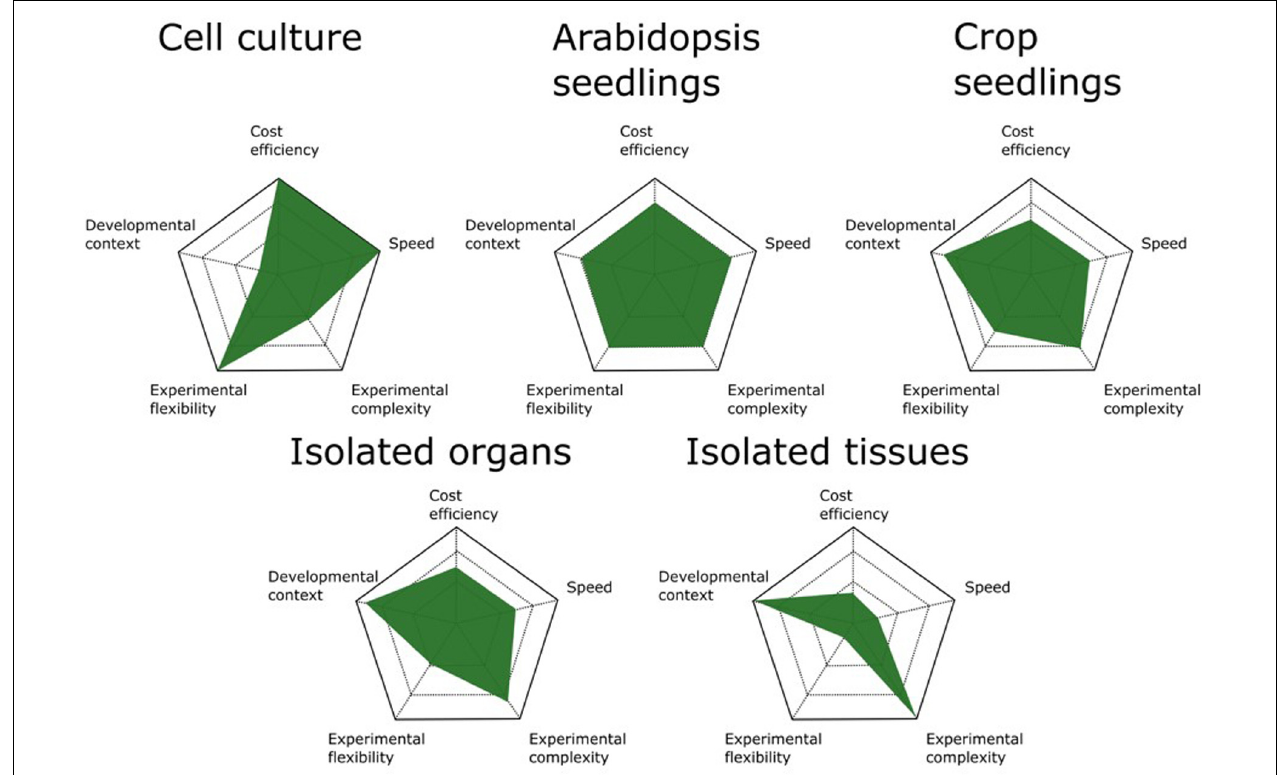
FIGURE 1 | Comparison of available biomass sources for AP/MS experiments. The advantages and disadvantages of different biomass sources are scaled on five parameters. Cell cultures are the most cost- and time-efficient means of generating biomass for AP/MS experiments. They also allow the highest experimental flexibility because of the ease with which they are manipulated by chemical compounds. Arabidopsis seedlings are the best all-round biomass source, offering the best performance for standard AP/MS experiments. When studying more specific developmental processes, crop seedlings can be better suited. However, these are more time consuming and often allow less experimental flexibility because of their size. Although isolated organs and tissues offer the highest degree of developmental context, determining the optimal tissue and developmental stage to harvest biomass increases the complexity of the experimental setup and the time